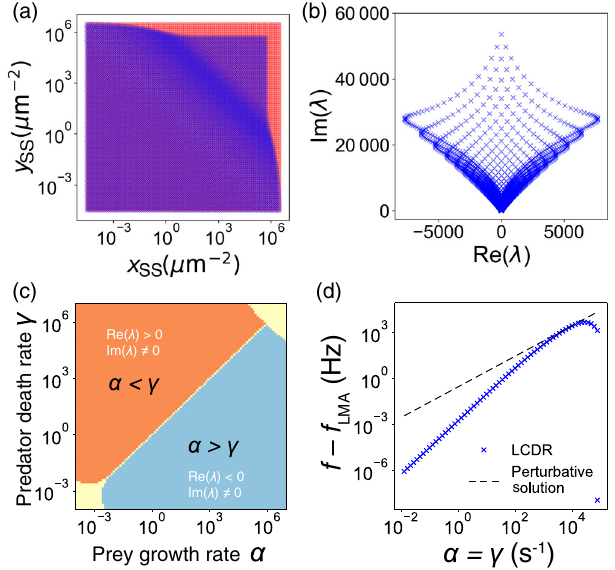
FIG. 6. Fine-tuning of oscillation: Solution of Lotka-Voterra predator-prey model using the LMA and LCDR leads to very different steady-state properties. (a) The steady-state prey ( x ) vs SS predator ( y ) concentration when the LMA is used (red dots) and SS when the LCDR is used (blue crosses). The compression of phase space shows that the LCDR constrains large variation in con- centration, which is consistent with Fig. 5. (b) The real part of the eigenvalues of the Jacobian vs their imaginary parts shows that most steady-state solutions are nonoscillatory when the LCDR is used. (c) The phase diagram of the Lotka-Volterra (LV) predator- prey system. Under the LCDR, sustained oscillation of concen- tration (pale yellow) happens only when α ¼ γ for a wide range of parameter values, which is a drastic reduction from the LMA, where oscillation occurs for all α and γ . (d) The deviation in the frequency of oscillation in the LCDR from that predicted by the LMA, f − f vs α in the parameter range where oscillation LMA happens only when α ¼ γ . Perturbation theory (see Appendix C) correctly captures the difference in a small range of α (dashed black